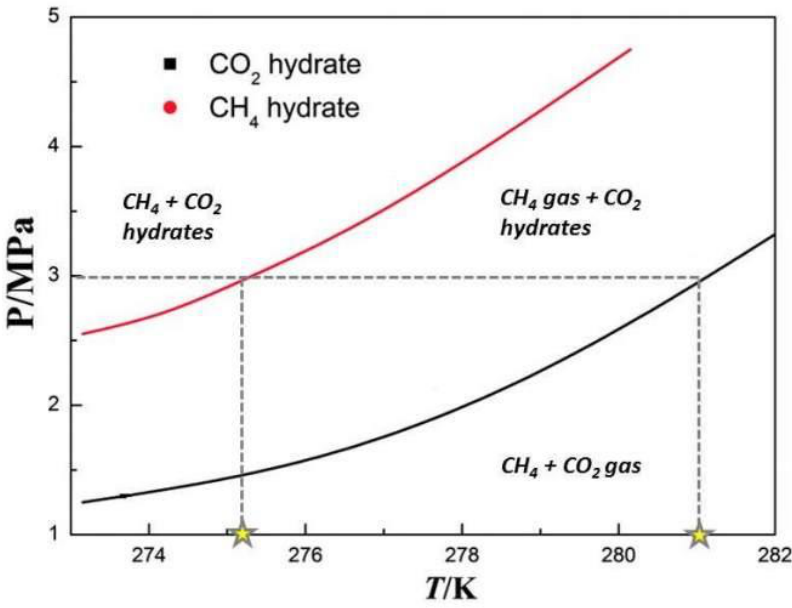
Figure 3. CH 4 and CO 2 CH equilibrium